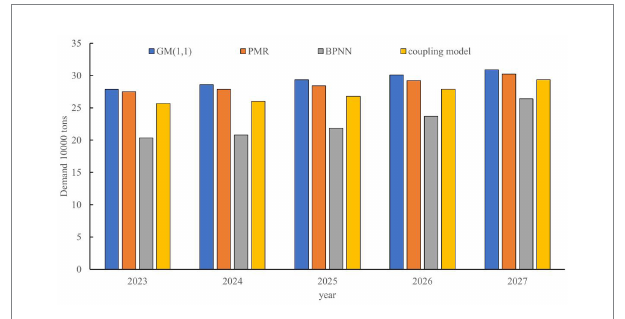
FIGURE 6 Comparison of forecast results of aquatic product CCL demand in